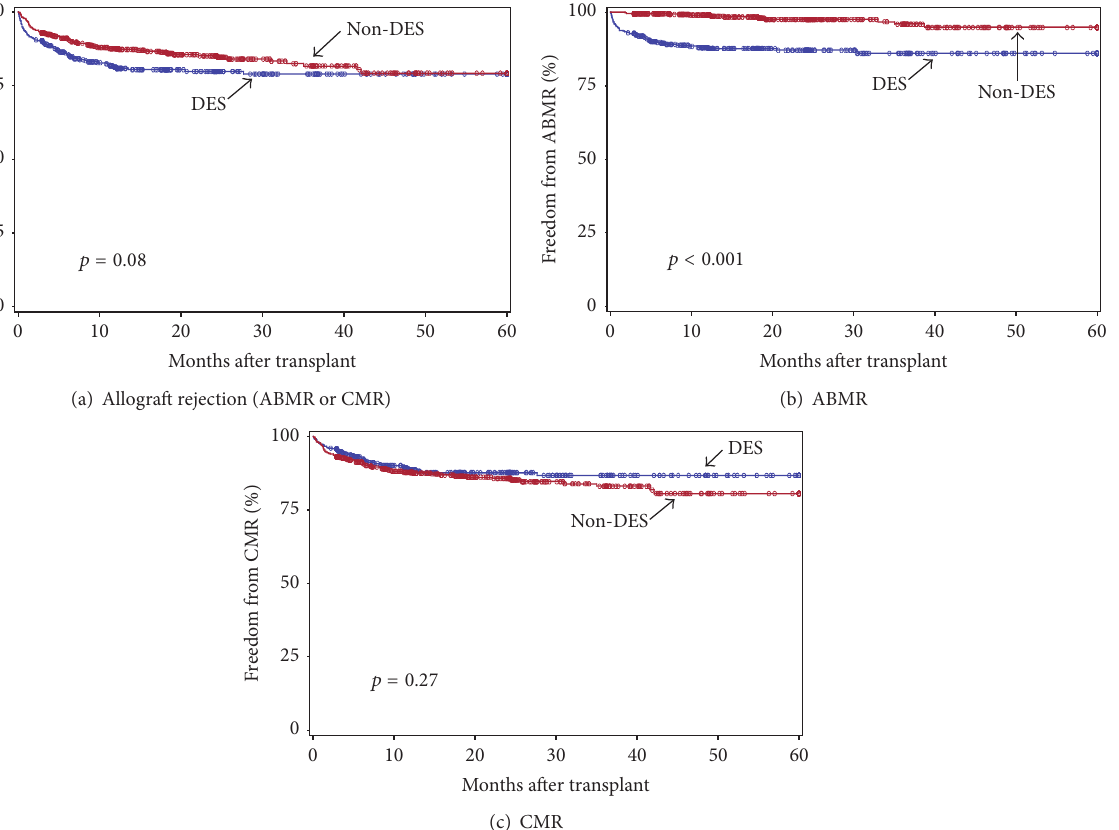
Figure 8: Freedom from overall allograft rejection (a), ABMR (b), and CMR (c) in DES (blue) versus non-DES (red) patients during the 1st 5 years after transplant. The group differences were assessed by the log-rank test.